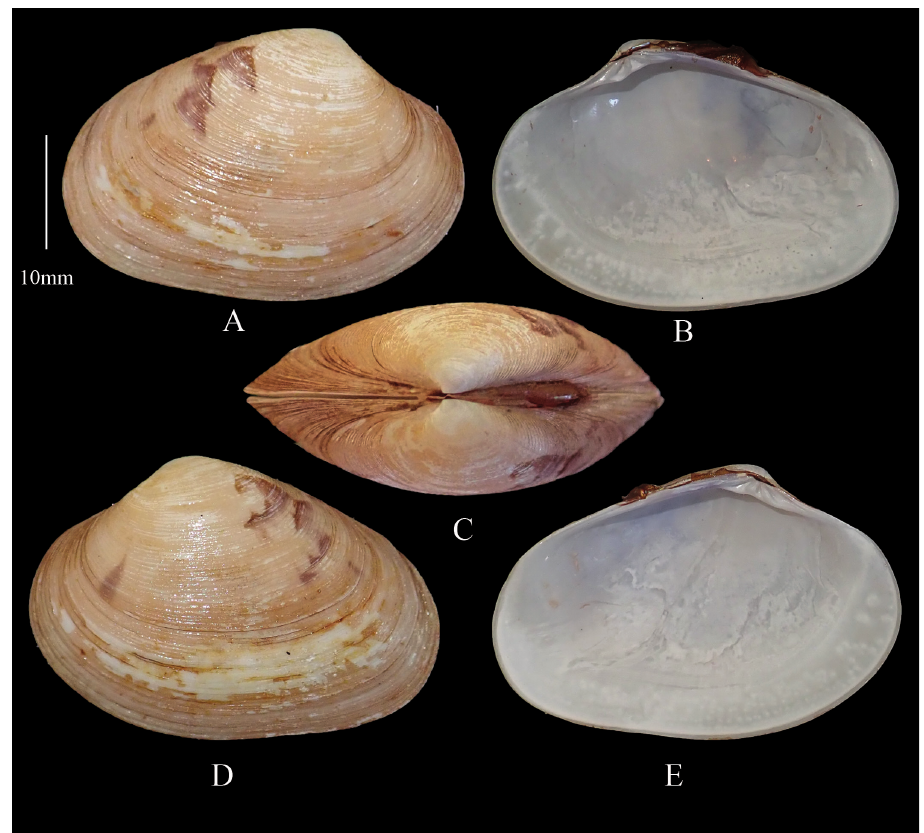
Figure 6. Marcia recens Morphotype 2 A right valve dorsal B right valve ventral C dorsal margin D left valve dorsal E left valve ventral (DABFUK), Ashtamudi Lake,